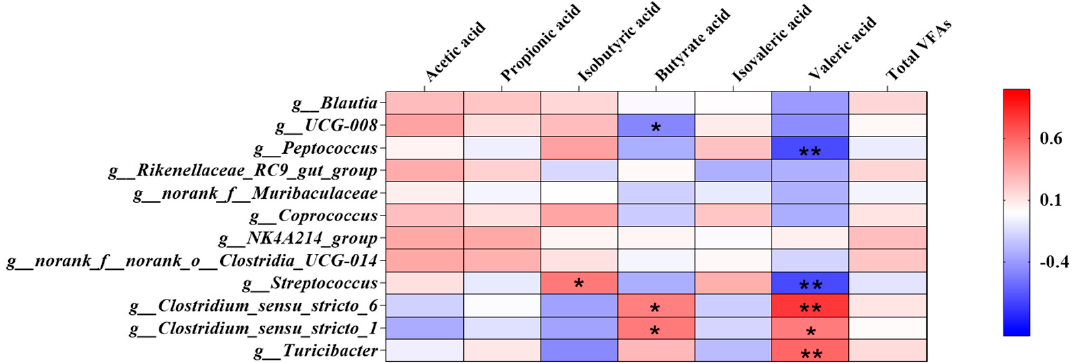
Figure 5. The correlation between the top 12 genera and the concentration of Colon SCFAs content. The individual pig was regarded as the experimental unit ( n = 6). NP, normal protein; LP, low protein; VLP, very low protein. “*” means there is a significant difference, “**” means a very significant difference.